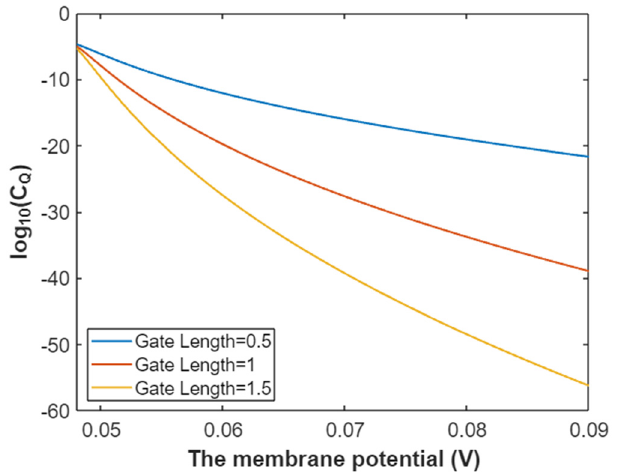
Figure 10. The relationship between membrane potential and the common logarithm of quantum conductance of a single sodium channel for the intracellular sodium ions at G = 6.33 J and over a membrane potential range from 0.048 V to 0.09 V.